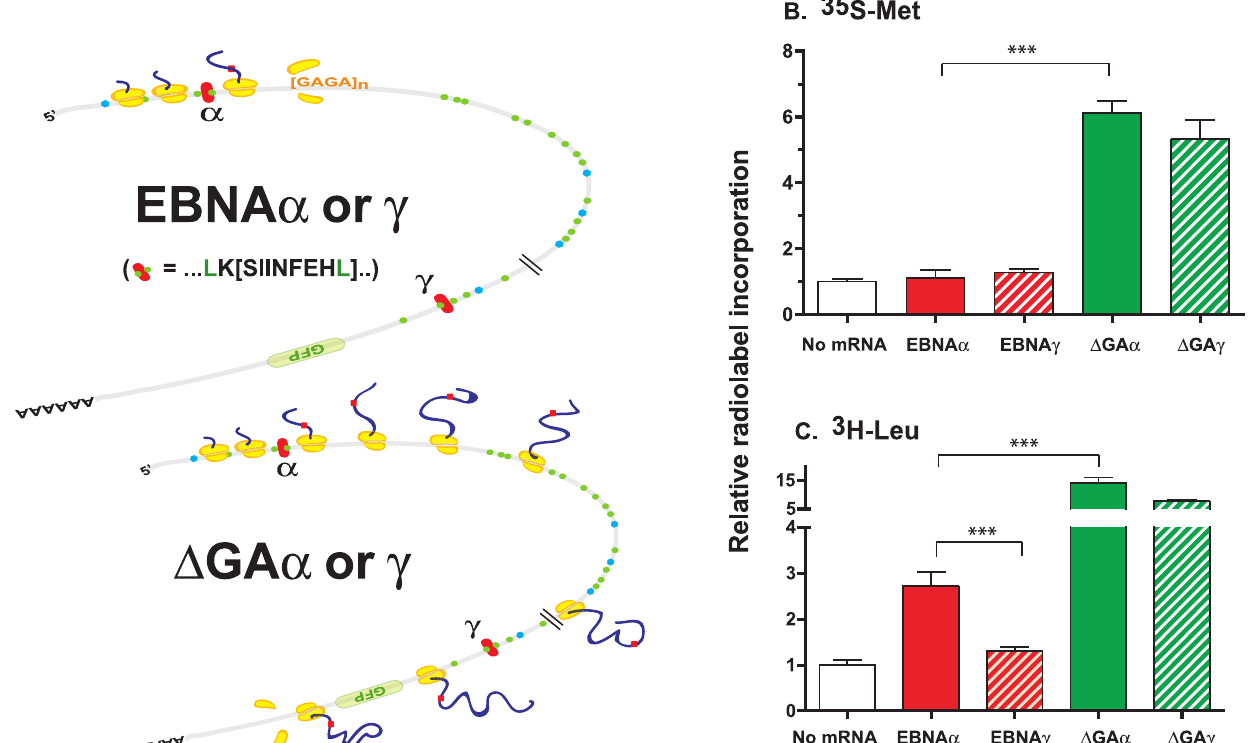
Figure 3. Ribosomes prematurely terminate translation within the 5 9 region of EBNA mRNA. ( A ) Schematic model to account for relative differences in the translational efficiency of EBNA or D GA mRNAs. The ribosomes initiate translation at the AUG codon (5 9 blue dot) of either EBNA or D GA mRNAs. However, translation is terminated within or close to the GAr region shown as [GAGA]n in the EBNA mRNA. The methionine and leucine codons are indicated as blue or green dots respectively. The inserted SHL8 nucleotides, at either the N-terminal ‘‘ a ’’ or the C-terminal ‘‘ c ’’ positions are shown as a red rectangle. All constructs included the indicated in-frame green fluorescent protein (GFP) sequence. ( B ) The mRNA coding for EBNA a , D GA a , EBNA c or D GA c were translated in vitro in the presence of 35 S-Met or 3 H-Leu for 1 h. Translation products were precipitated with trichloroacetic acid and collected by filtration. Radioactivity measured by liquid scintillation is shown as relative counts per minute compared to no mRNA control. Bars are average of 5 different experiments ( 6 standard deviation). Standard t -test was used to calculate statistically significant differences shown as asterisks (***: p , 0.001).